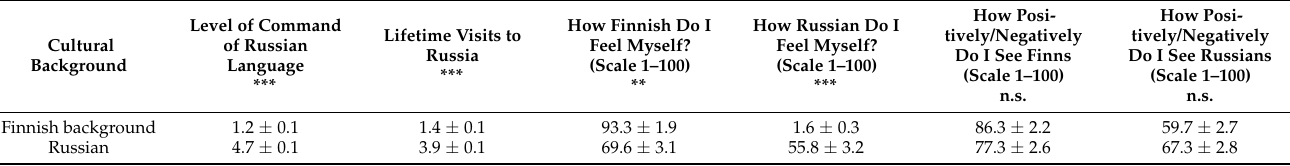
Table 1. Results from the background